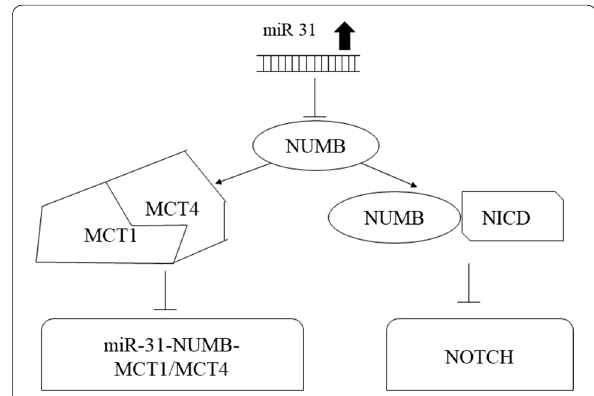
Fig. 2 Influence of miR31 on pathways. The figure represents the possible mechanisms of how miR31 affects the miR-31-NUMB-MCT1/ MCT4 and NOTCH